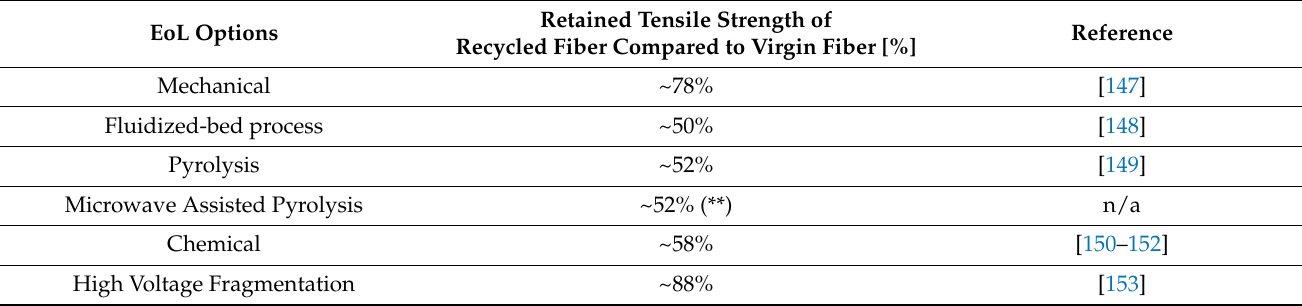
Table 5. Recycled GF retained tensile strength compared to virgin GF: (**) No reference found, estimated to be the same as conventional pyrolysis as the processing conditions are similar. Taken from